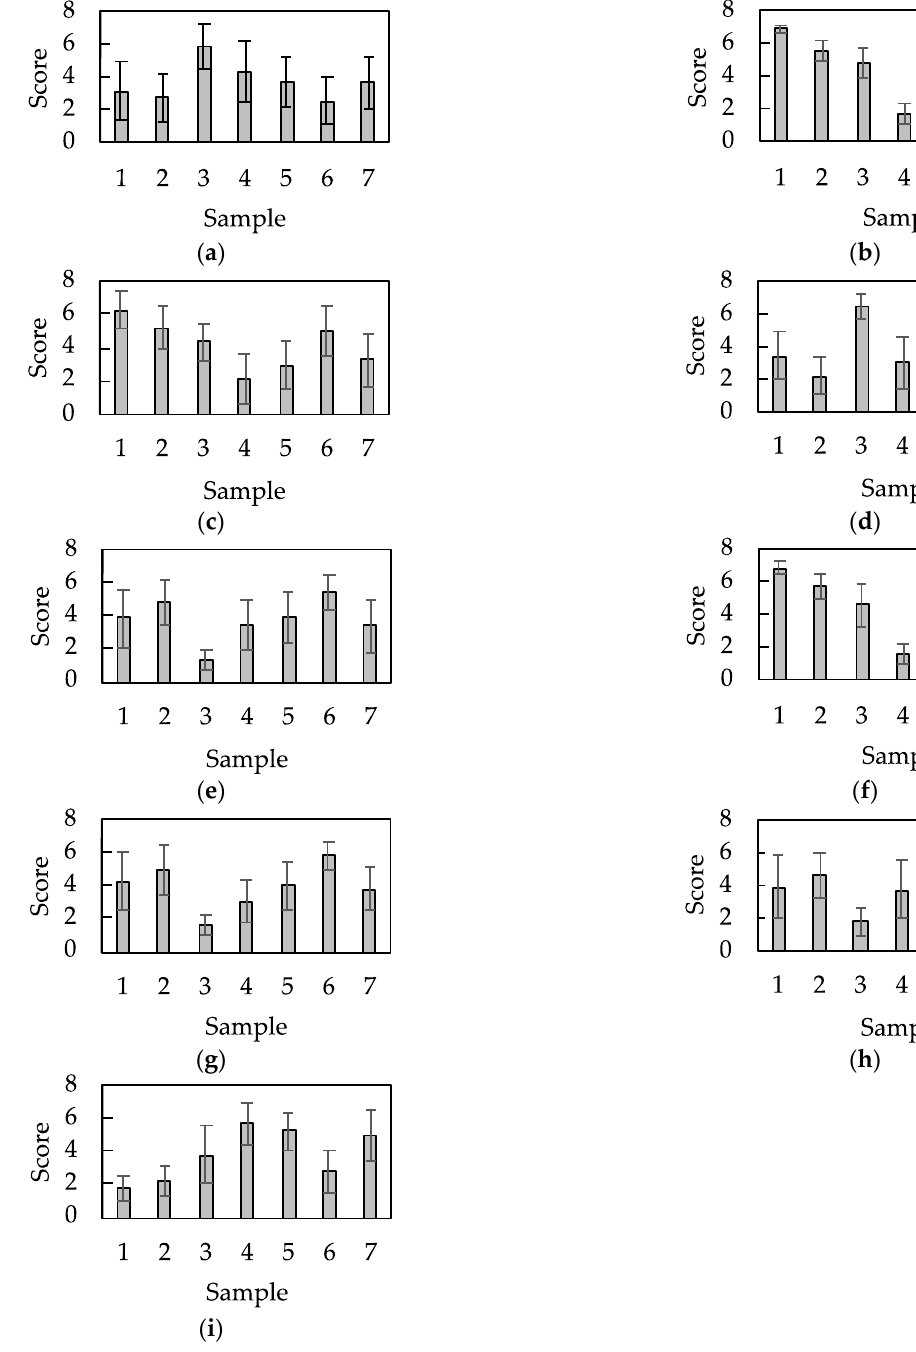
Figure 6. Results of the sensory evaluation of the seven aluminum samples. A semantic differential method with a seven- step unipolar scale was employed for sensory evaluation. ( a – i ) represent the words, ( a ) rough, ( b ) uneven, ( c ) coarse, ( d ) prickly, ( e ) smooth, ( f ) rugged, ( g ) slippery, ( h ) sleek, and ( i ) dry ( 𝑛 = 14, 𝑚𝑒𝑎𝑛 ± 𝑆𝐷) .